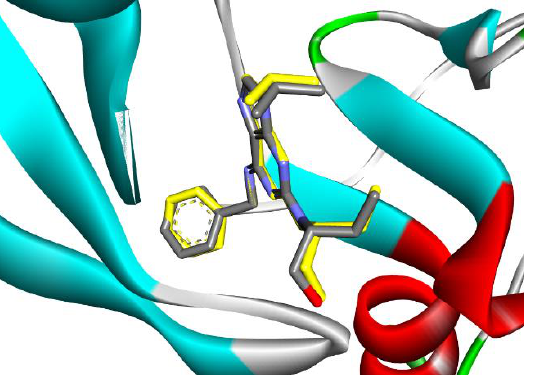
Figure 6. The superposition of cocrystal ligand (Roscovitine) with its docked pose showed an appreciable RMSD of 0.48 Å. Table 7. Types of interactions of tritriacontane, limonene, and 13,17-dimethyltritriacontane within CKD-2 and HAV 3C protease active site.